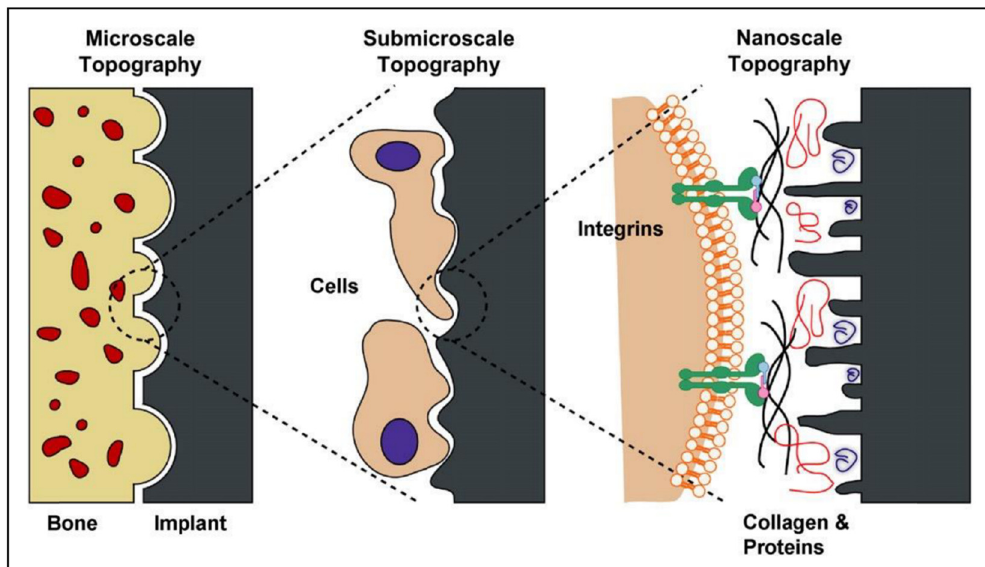
Figure 24: Schematic illustration of the three levels of interactions between the bone and implant. At the macroscale level, the implant supplies acceptable mechanical stability to the bone. At the micro/ submicroscales, the implant is able to directly interact with osteoblasts and MSCs. At the nanoscale, cell membrane receptors, such as integrins, can recognize proteins adsorbed on the surface, which in turn are modulated by the nanostructures on the surface [ 342 ] . Copyright 2014, Elsevier ™ .